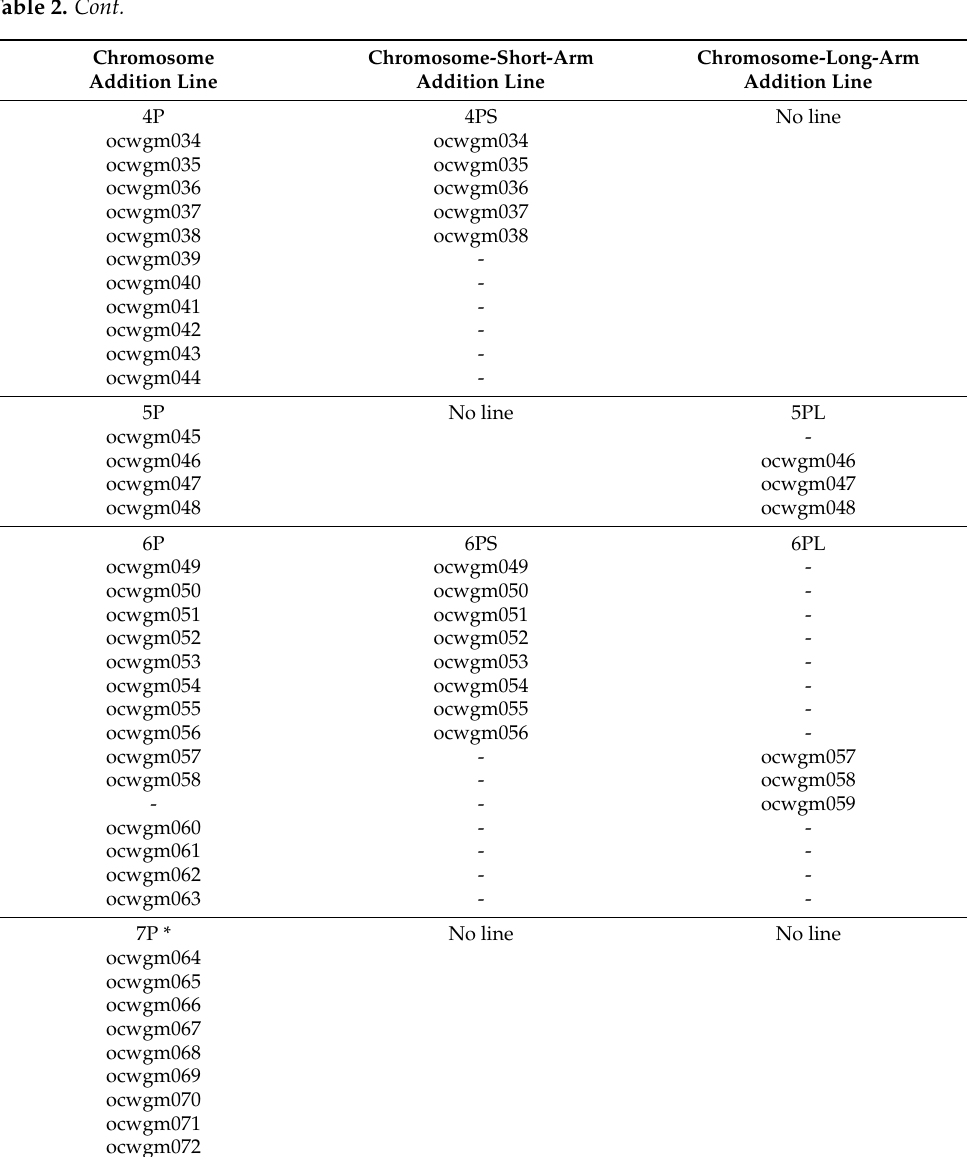
Table 2. Cont. Chromosome Addition Line